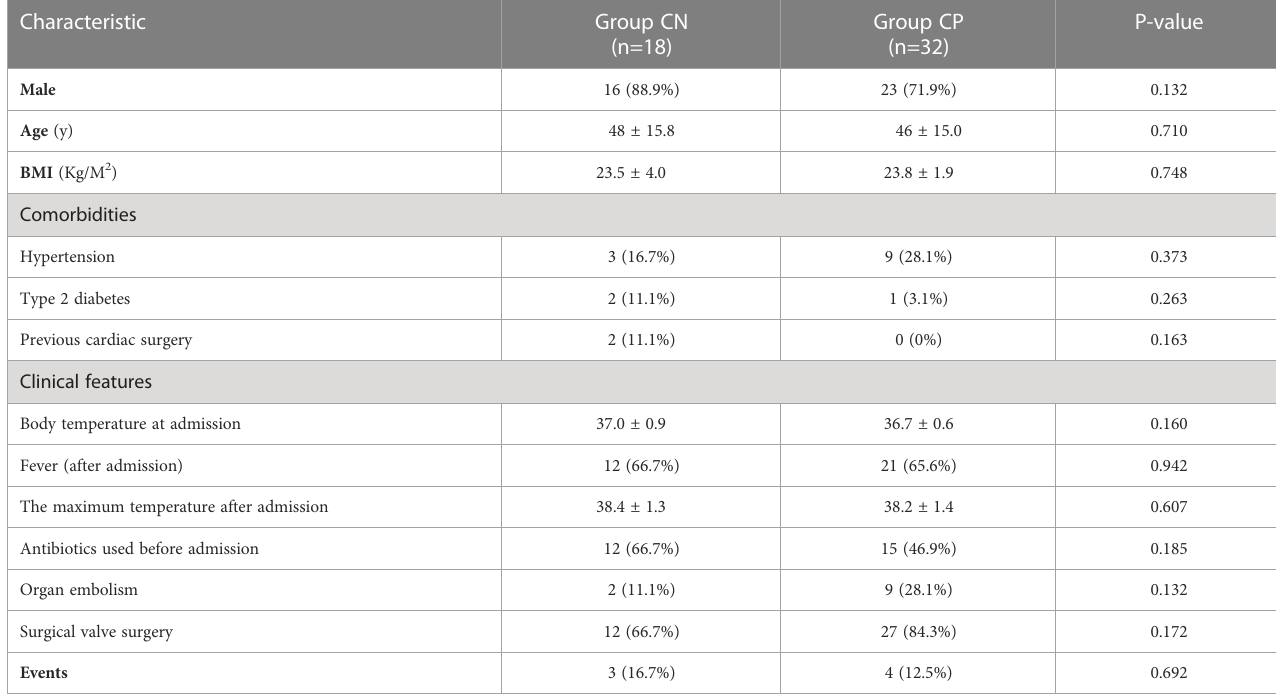
TABLE 1 Clinical characteristics of culture-negative IE and culture-positive IE patients.